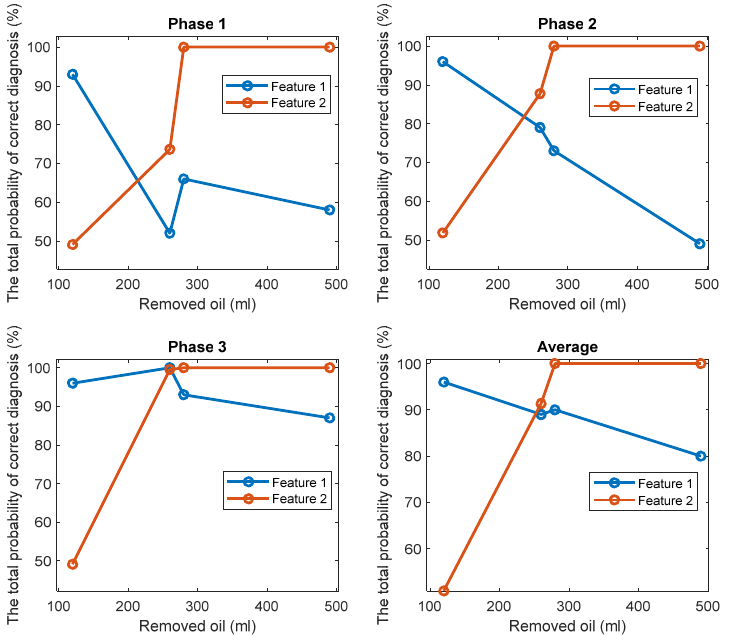
Figure 16. The TPOCD, provided by technology 1 and technology 2, respectively, for three phases and 4 levels of oil removal compared to the standard oil level (Day 2).